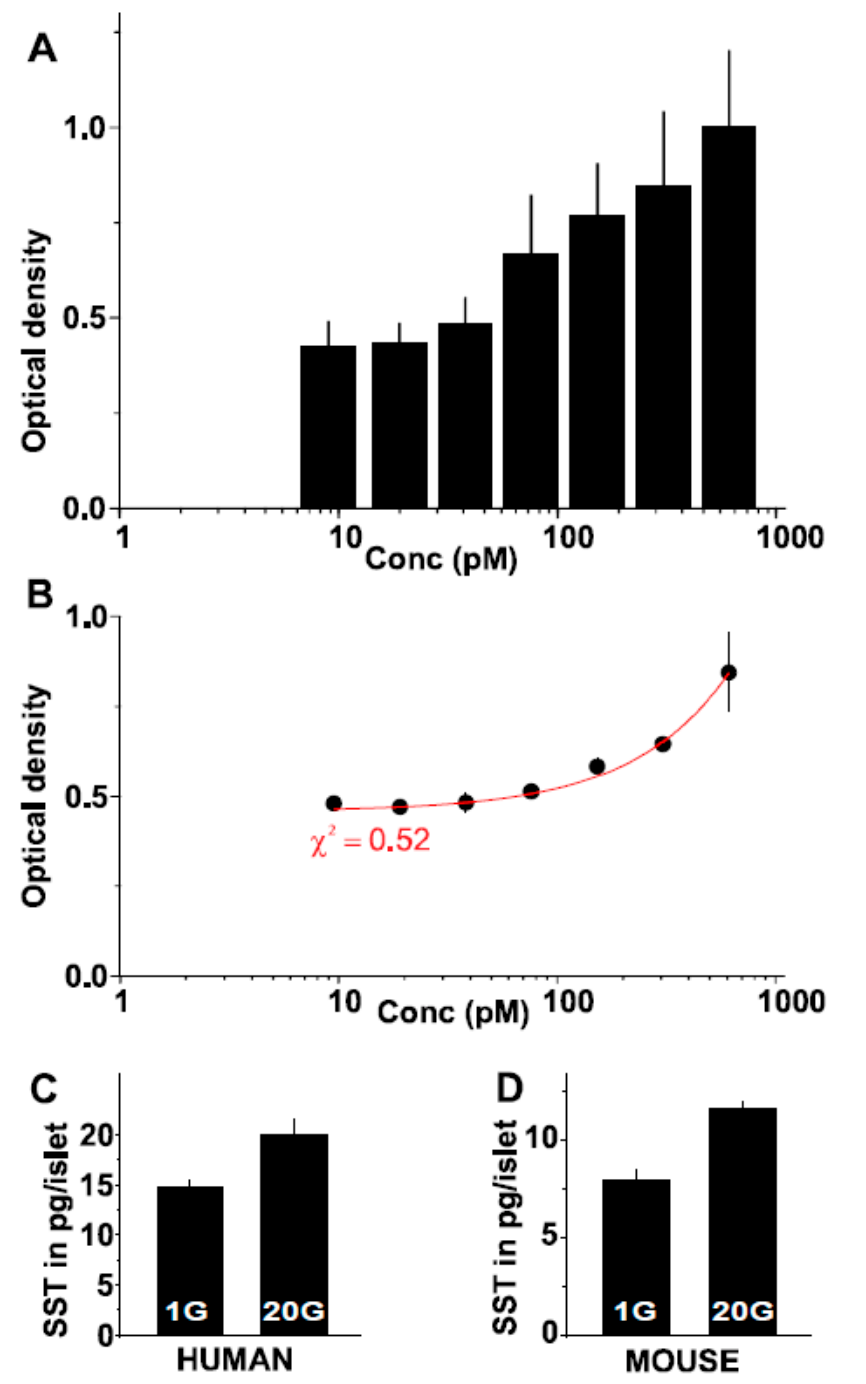
Figure 6. Assay to detect SST secretion with varying glucose concentrations—( A ) Optical density plotted against the concentration of SST diluted to prepare standards, ( B ) Same as ( A ) but fitted with exponential decay function with chi-square value of 0.52, ( C ) SST secretion interpolated against the curve from human islets treated with 1 and 20 mM glucose (1G and 20G groups respectively). Each experiment was repeated with 3 replicates using 3 donor islets (received on sperate days), ( D ) SST secretion interpolated against the curve from mouse islets treated with 1 and 20 mM glucose (1G and 20G groups respectively). Each experiment was repeated with 3 replicates using on two different days using 3–6